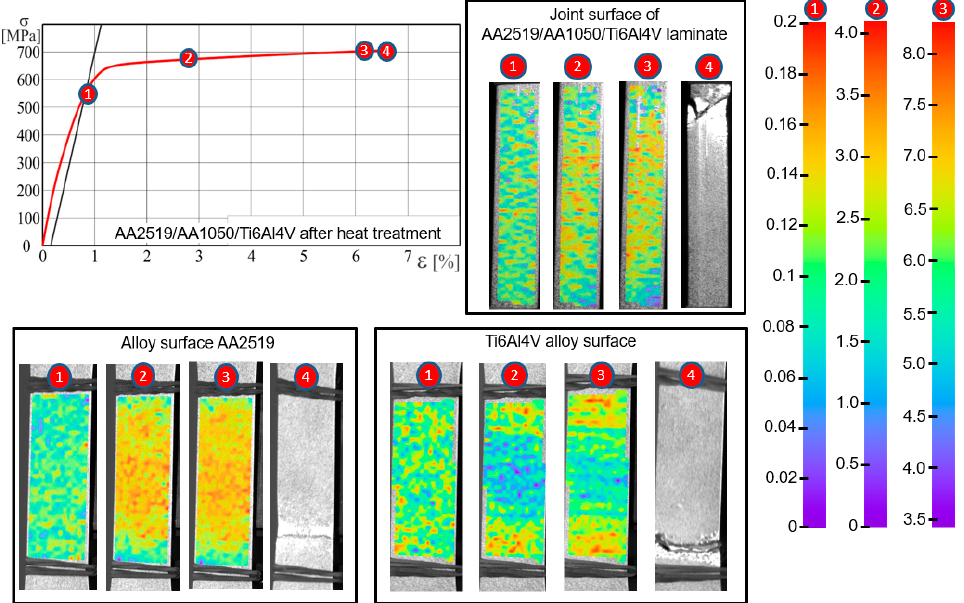
Figure 11. Strain distribution using DIC method for selected points of the stress-strain curve obtained for AA2519-Ti6Al4V laminate with interlayer of AA1050 after heat treatment: 1—The yield strength R0.2; 2—the plastic strain of 2%; 3—the ultimate strength Rm; 4—the fracture of the specimen.